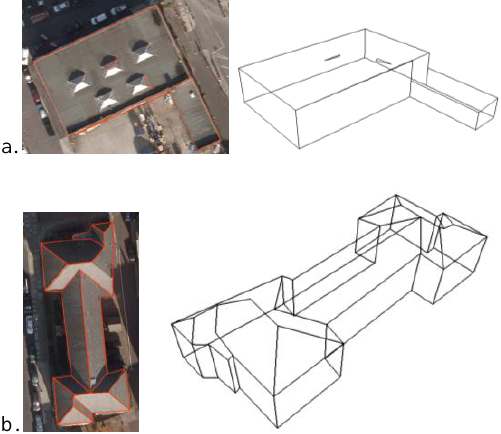
Table 2: Quantitative analysis to determine